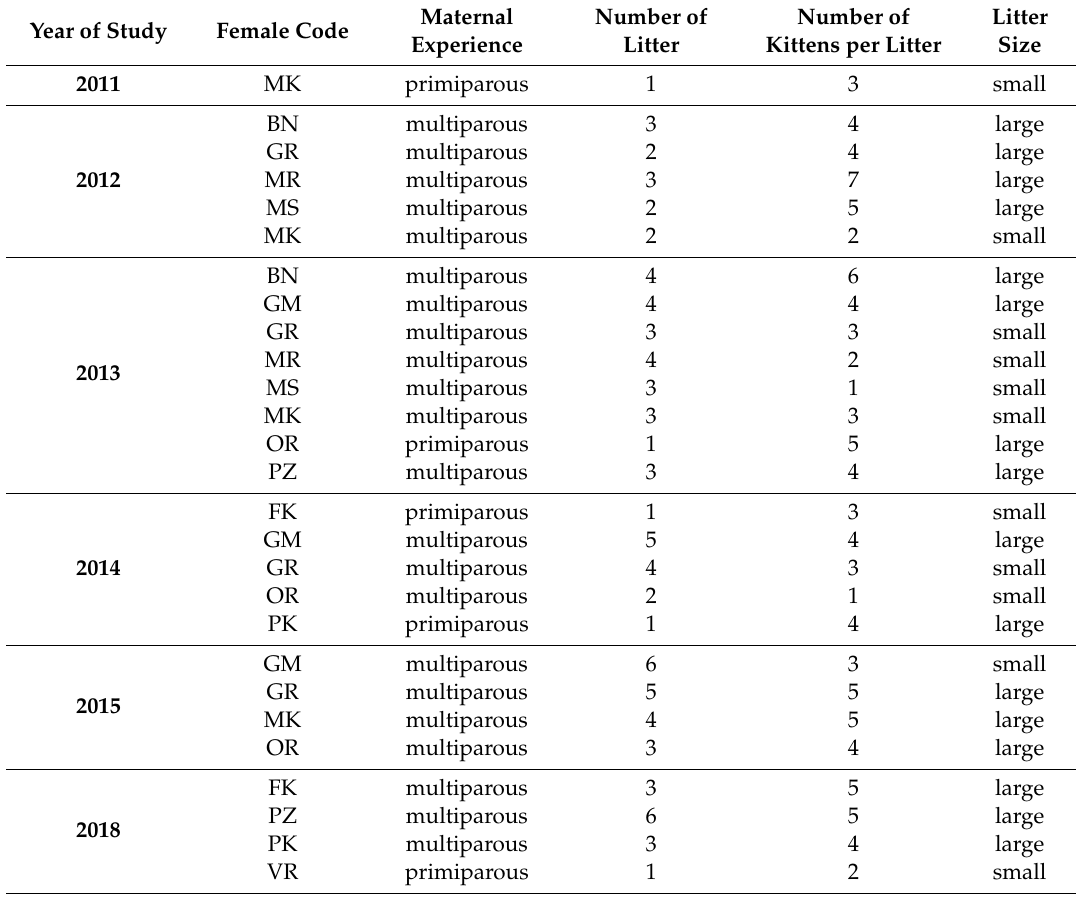
Table 1. Females used in the study, their maternal experience, and litter size in di ff erent